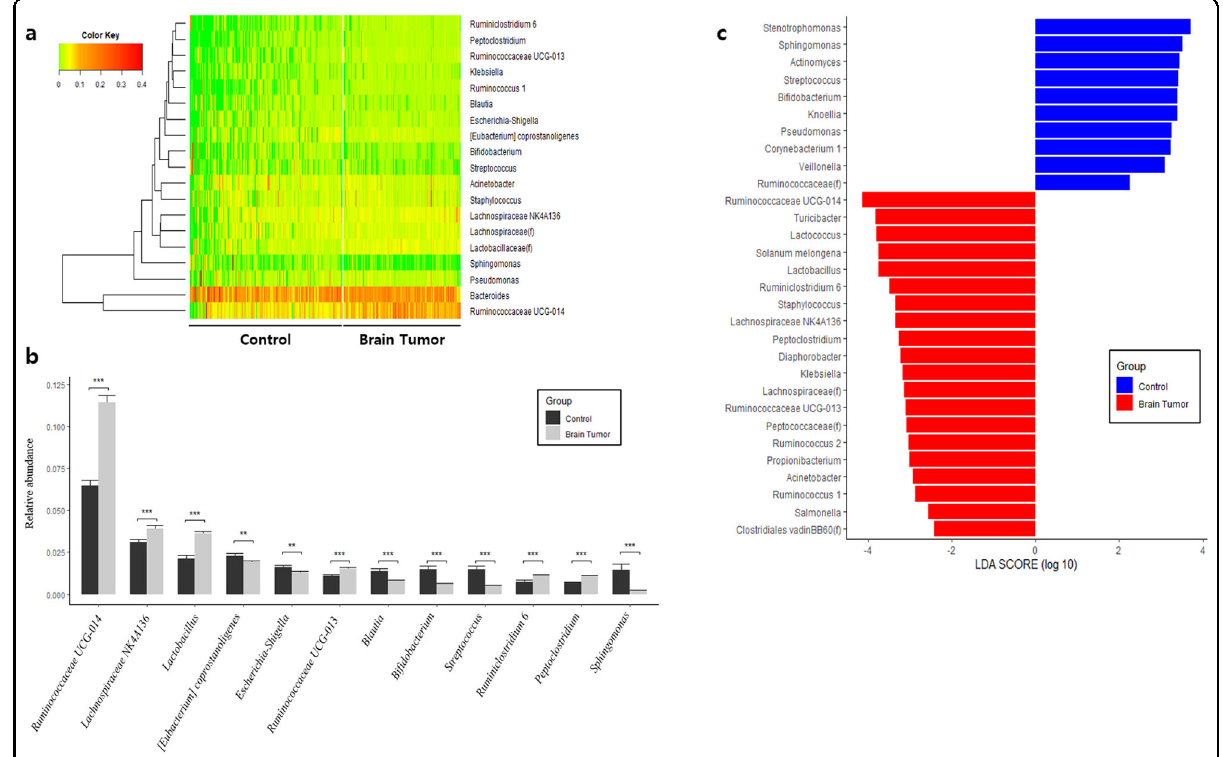
Fig. 3 Differences in microbiome abundance between healthy control (HC) subjects and brain tumor (BT) patients in serum at the genus level. a Heatmap of serum microbial EV abundance. b Major bacterial EVs and signi fi cant difference between the HC and BT groups by t -test (>1% in any group). c Signi fi cantly different bacterial EVs determined through LEfSe analysis (>2 log(LDA